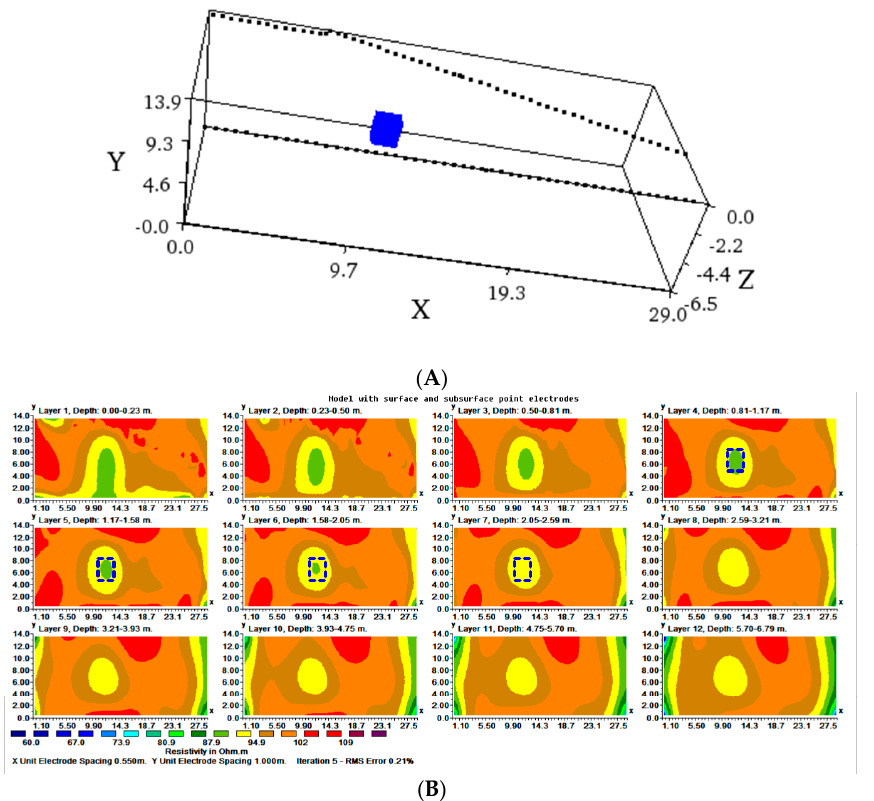
Figure 6. The model and the inversion results: ( A ) The synthetic model ( B ); The inversion results of the model, rectangle is the location of abnormal body.